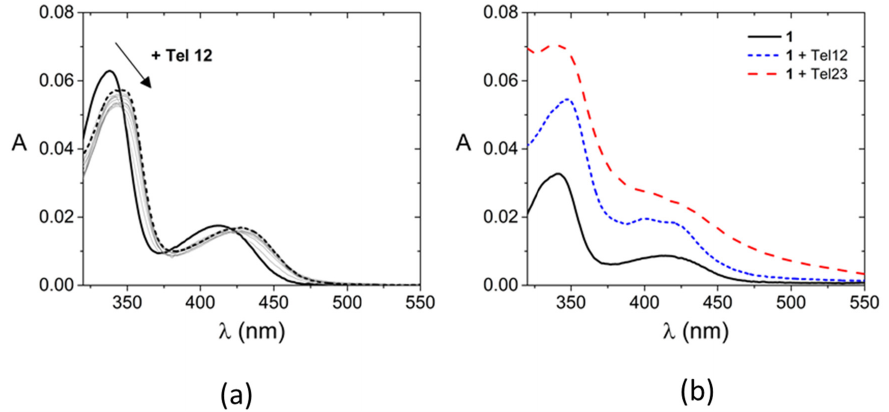
Figure 1. ( a ) Examples of spectrophotometric titrations for the 4 /Tel12 system ([ 4 ] = 3.88 × 10 − 6 M, [Tel12] from 0 M (full line) to 2.02 × 10 − 5 M (dashed line), KCl 0.1 M, NaCacodylate 2.5 mM, pH 7.0, 25 °C). ( b ) Absorbance profile of 1 alone and in the presence of Tel12 or Tel23 excess ([ 1 ] = 3.88 × 10 − 6 M, [Tel12] = 2.02 × 10 − 5 M, [Tel23] = 2.02 × 10 − 5 M, KCl 0.1 M, NaCacodylate 2.5 mM, pH 7.0, 25 °C). Table 1. Spectroscopic features, binding constants values and G ‐ quadruplex melting temperature changes observed for the studied systems. KCl 0.1 M, NaCacodylate 2.5 mM, pH 7.0, 25 °C. Tel12 Tel23